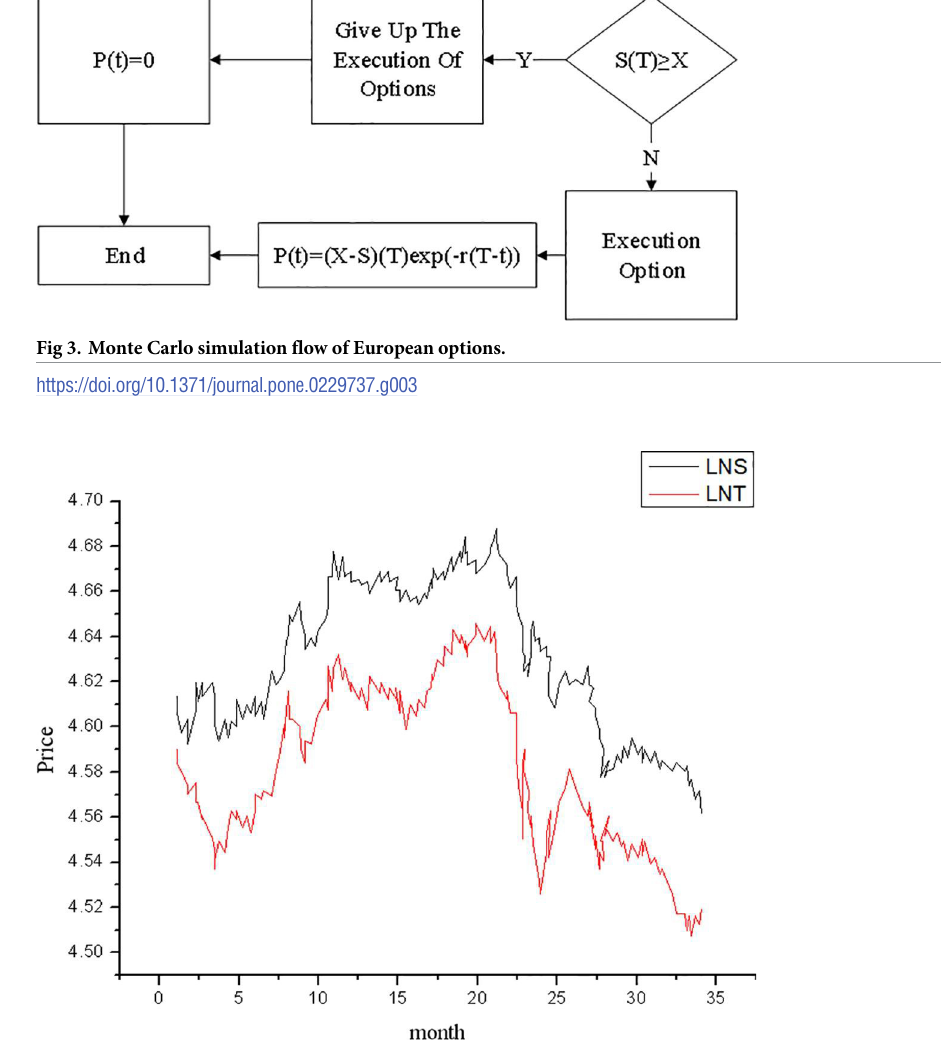
PLOS ONE | https://doi.org/10.1371/journal.pone.0229737 February 27,